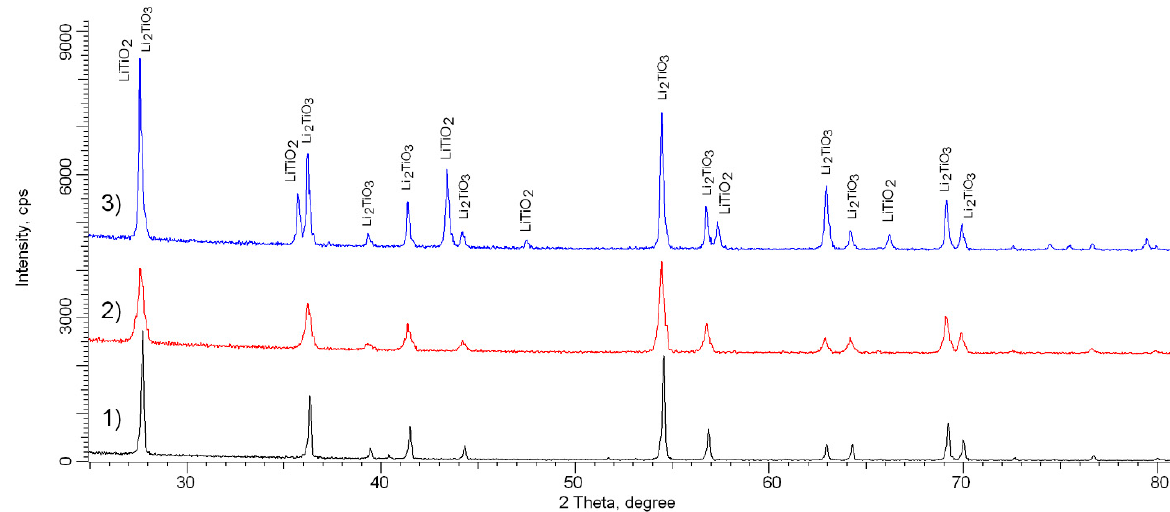
Figure 1. X-ray diffraction patterns of the samples under study: 1 ) LTO-1; 2 ) LTO-2; 3 ) LTO-3.